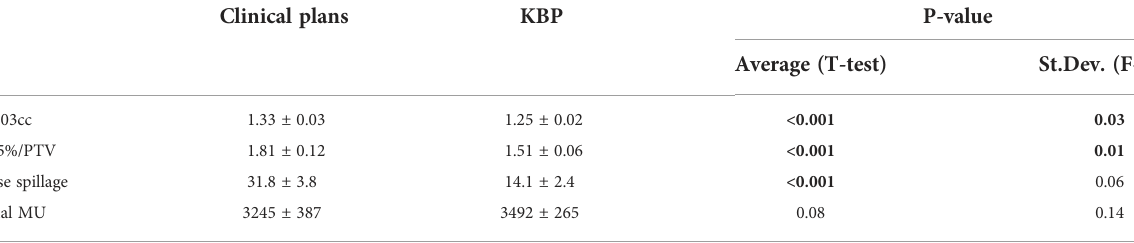
TABLE 3 Comparison of plan